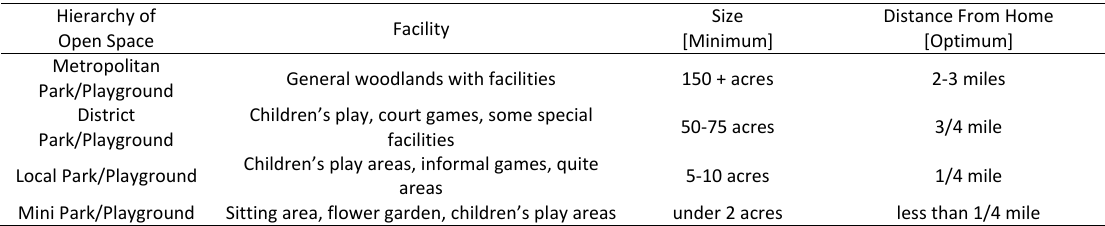
Table 1: Planning standard for urban recreational open spaces in Dhaka (RAJUK, 2016) Hierarchy of Open Space